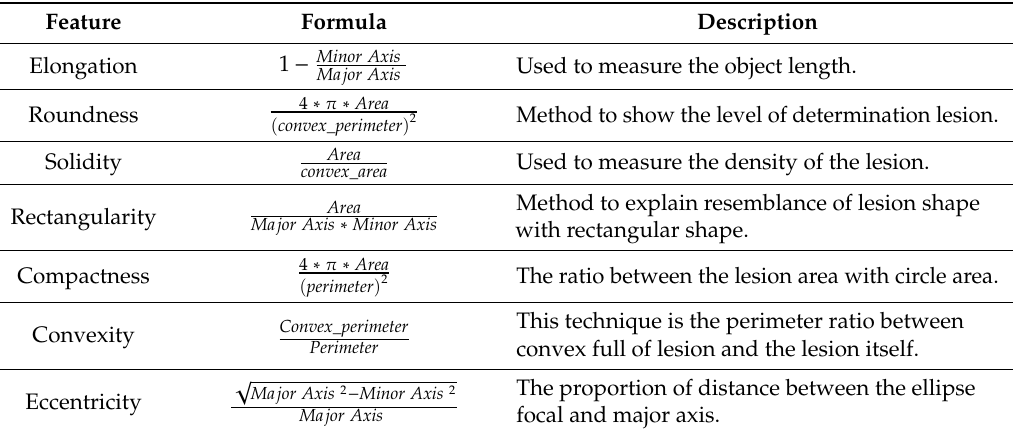
Table 3. Formula of shape-based features.